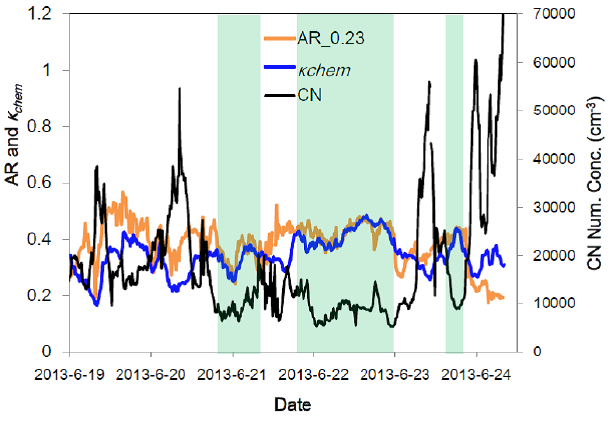
Figure 10. Time series of bulk AR at SS = 0.23%, derived κ chem , and N CN from 19–24 June 2013. Green shaded areas highlight pe- riods with high correlations between bulk AR and κ chem